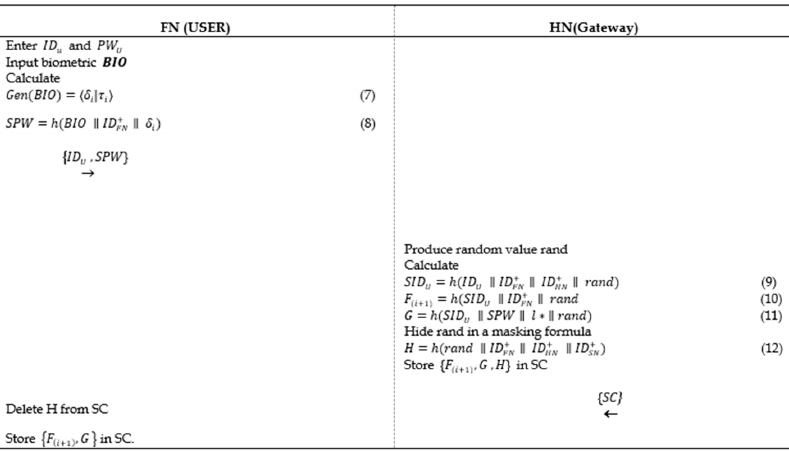
Figure 2. The proposed scheme registration phase.